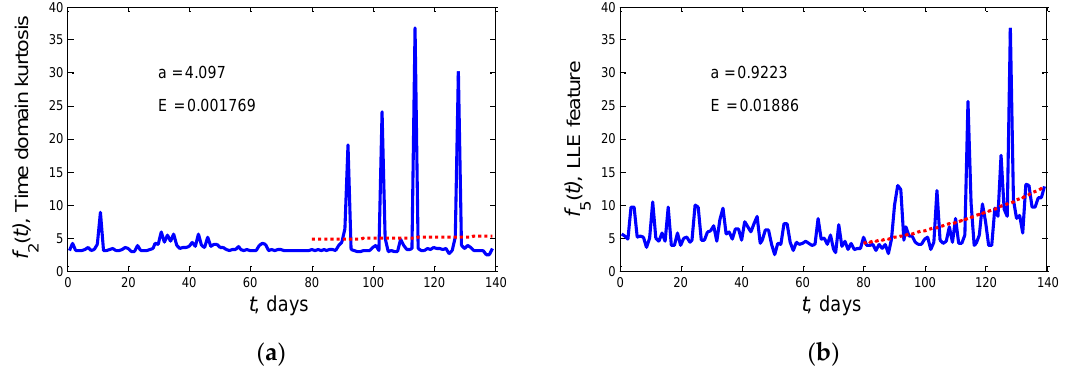
Figure 9. Evaluation criterion ( E ) calculation: ( a ) time domain kurtosis feature; ( b ) LLE feature.